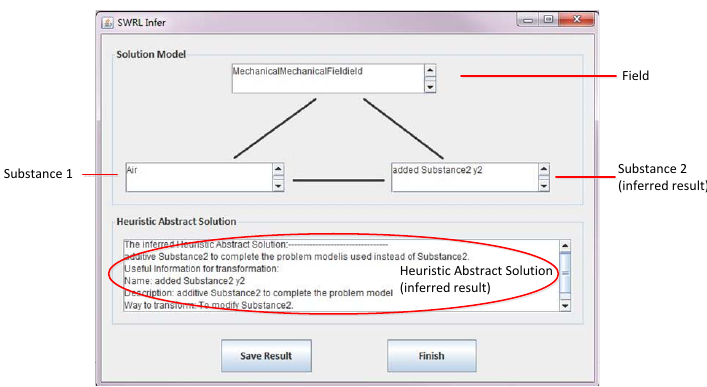
Figure 9. Choose appropriate inventive standard for the case of the “Auguste Piccard’s Stratostat”.